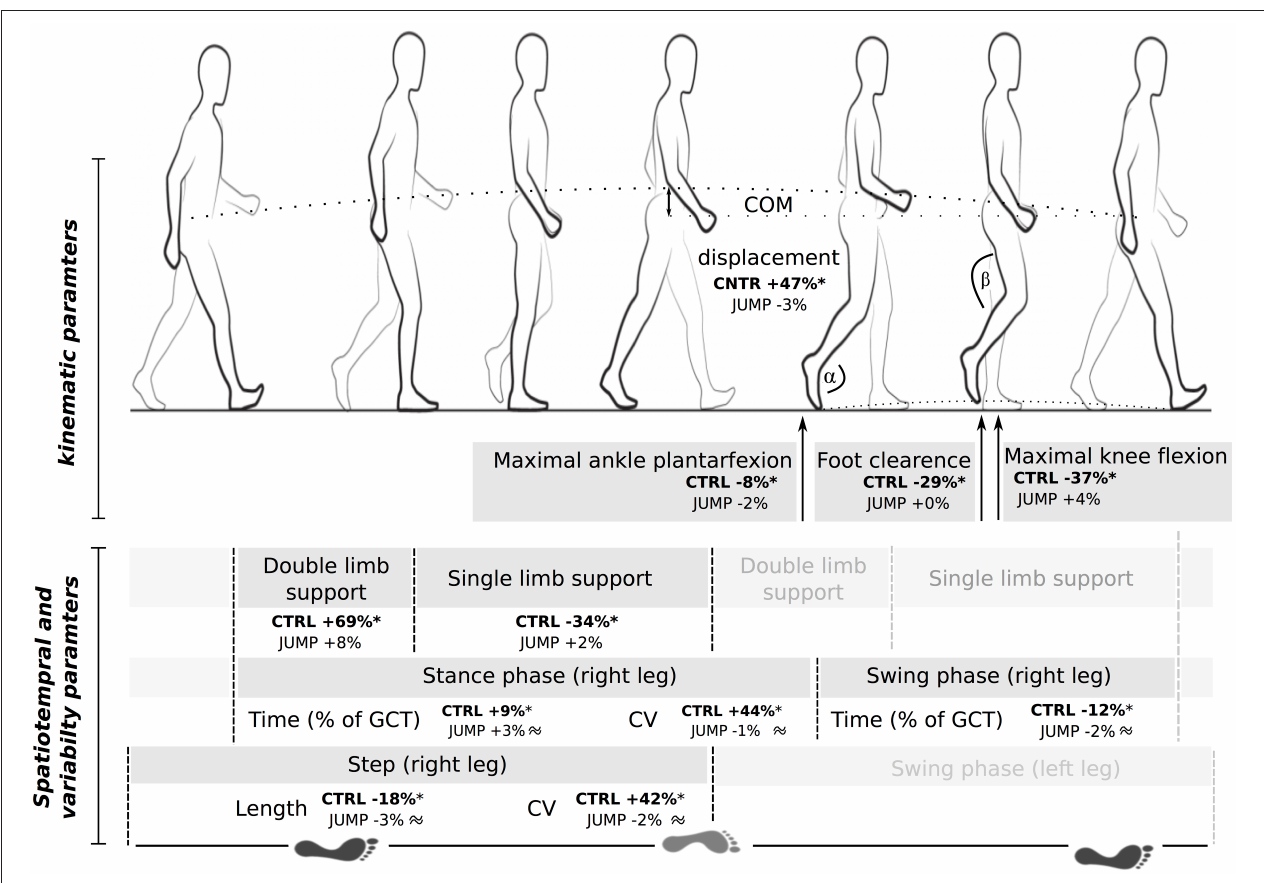
FIGURE 4 | Gait characteristics of the inactive CTRL and JUMP group after bed-rest illustrated for one stride. Changes refer to R + 0 normalized to BDC-1. Swing phase, double and single limb support are expressed as %-changes normalized to the gait cycle time (GCT). Values are means ± SE. * indicates a significant difference and the ≈ symbol non-inferiority compared to baseline. CV, coefficient of variance; GCT, gait cycle time; COM, center of